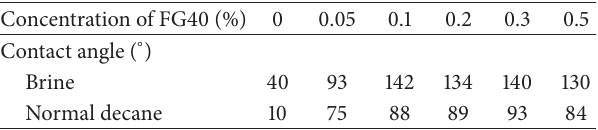
Table 3: Contact angle of the sandstone after treatment with FG40. Concentration of FG40 (%)